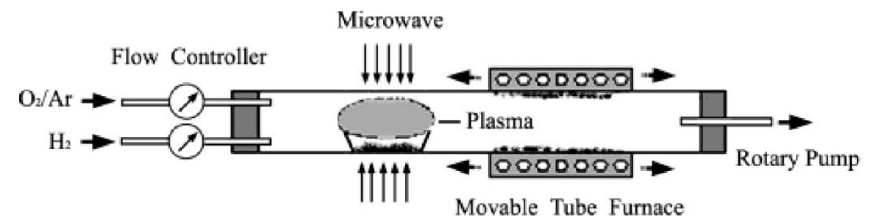
Figure 83. Schematic illustration of the microwave plasma system for Zn-ZnO nanocables and ZnO nanotubes growth. Reprinted (adapted) with permission from [899]. Copyright © 2003, American